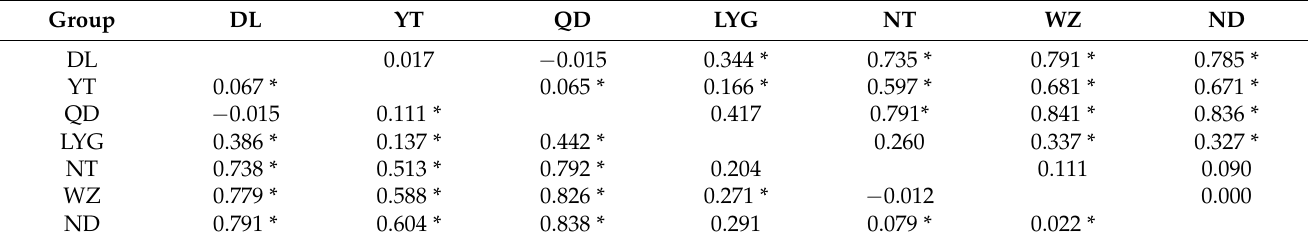
Table 3. F st between populations of L. ( N. ) beka, based on COI (below diagonal) and 16S (above diagonal).